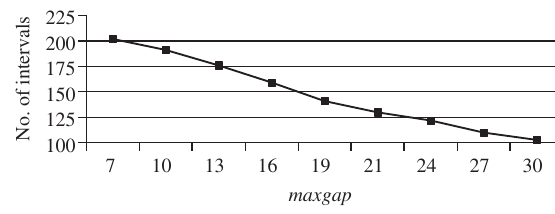
Figure 8. BMS-WebView-1 ( minsupp = 0.06, mininterval = 7).